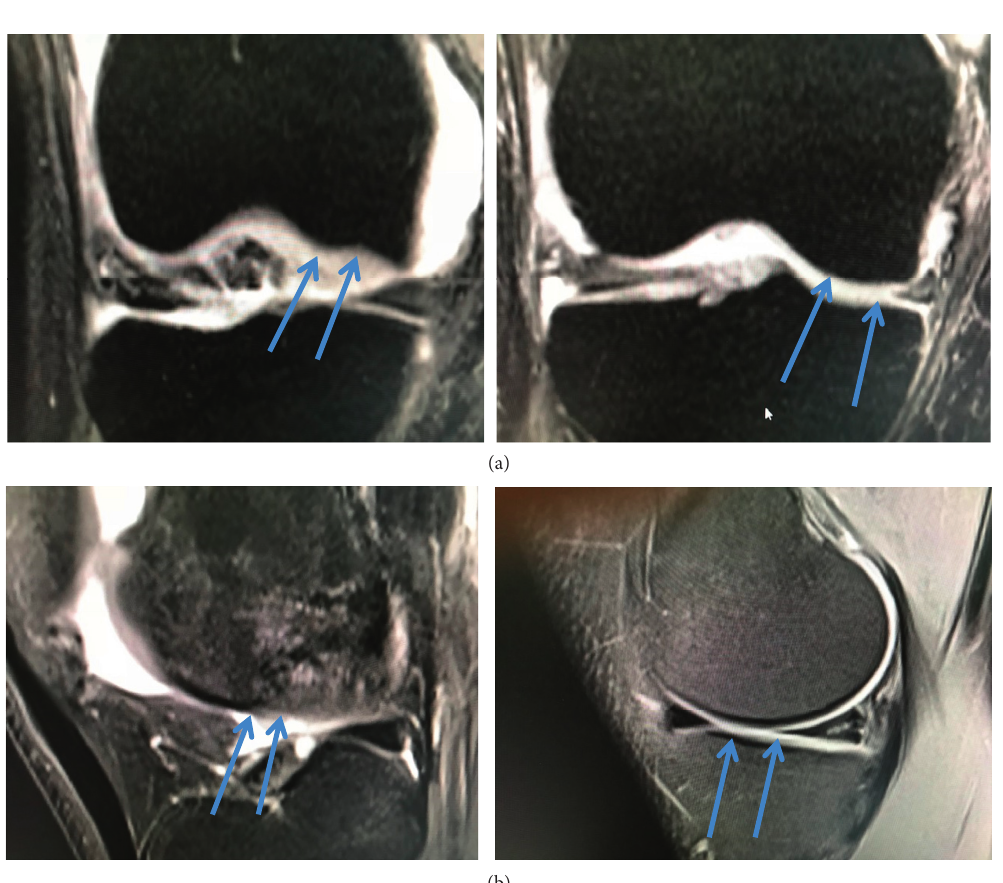
Figure 2: (a) AP view of the MRI of the knee joint showing depression in the femoral condyle (blue arrows) due to the damaged cartilage which completely recovered post injection of ABMDC. (b) Lateral view of the MRI of knee joint with erosion of the cartilage of the femoral condyle and post-injection regeneration of the damaged cartilage (blue